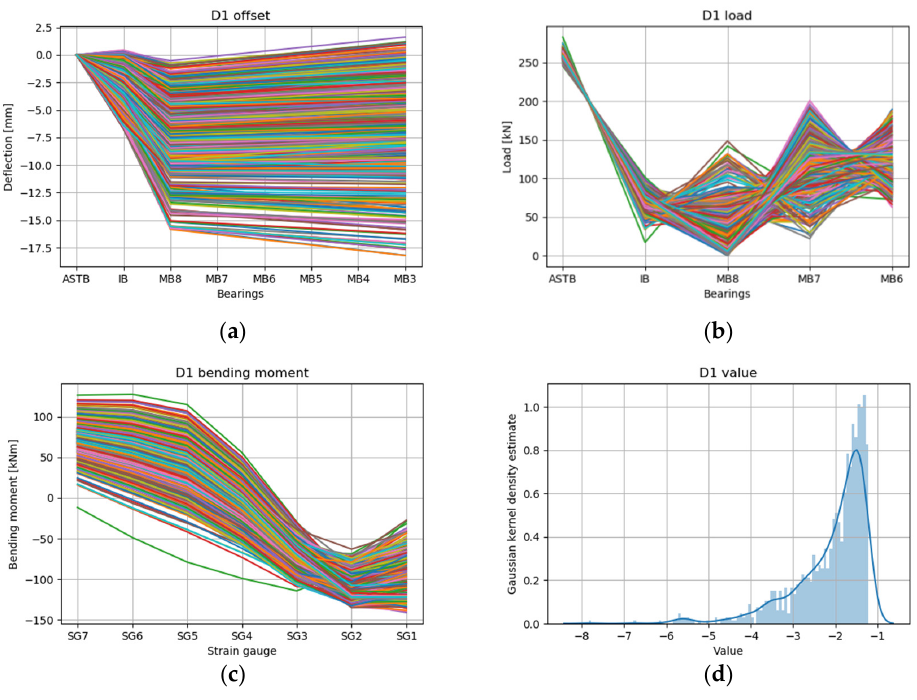
Figure 15. RL results for draft condition D1 all cases: ( a ) offset, ( b ) load, ( c ) bending moment, and ( d ) value.